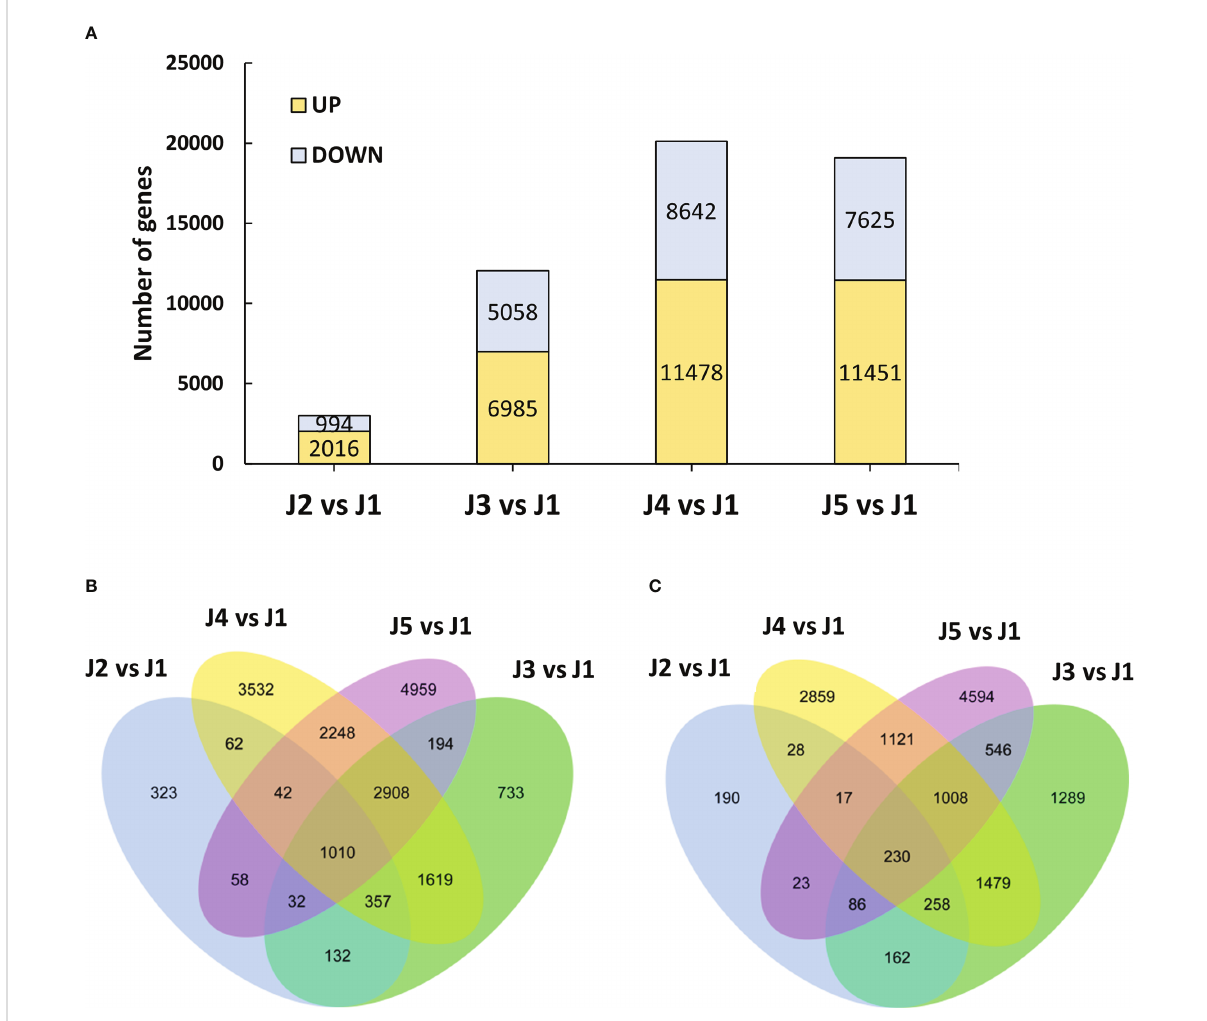
FIGURE 2 Overview of the transcriptome analysis. (A) Differentially expressed genes at each timepoint compared to control plants. (B) Venn diagram for the up-regulated genes shared by each time point after -2.5°C freezing treatment. (C) Venn diagram for the down-regulated genes shared by each time point after -2.5°C freezing